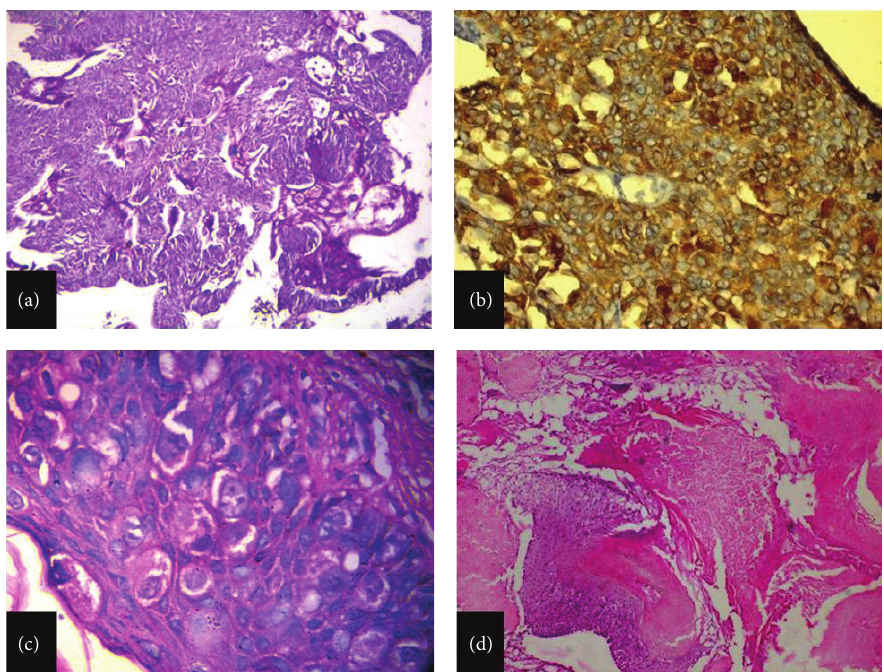
Figure 3: (a) Sweat gland tumour, showing prominent papillary epithelial projections (H&E, × 50). (b) Sweat gland tumour, showing CK5/6 positivity in the tumour cells (Immunoperoxidase, × 100). (c) Paget’s disease, showing large rounded Paget cells with ample pale staining cytoplasm (H&E, × 400). (d) Pilomatricoma, showing rounded basophilic cells and shadow cells with loss of nuclei and distinct border (H&E, ×